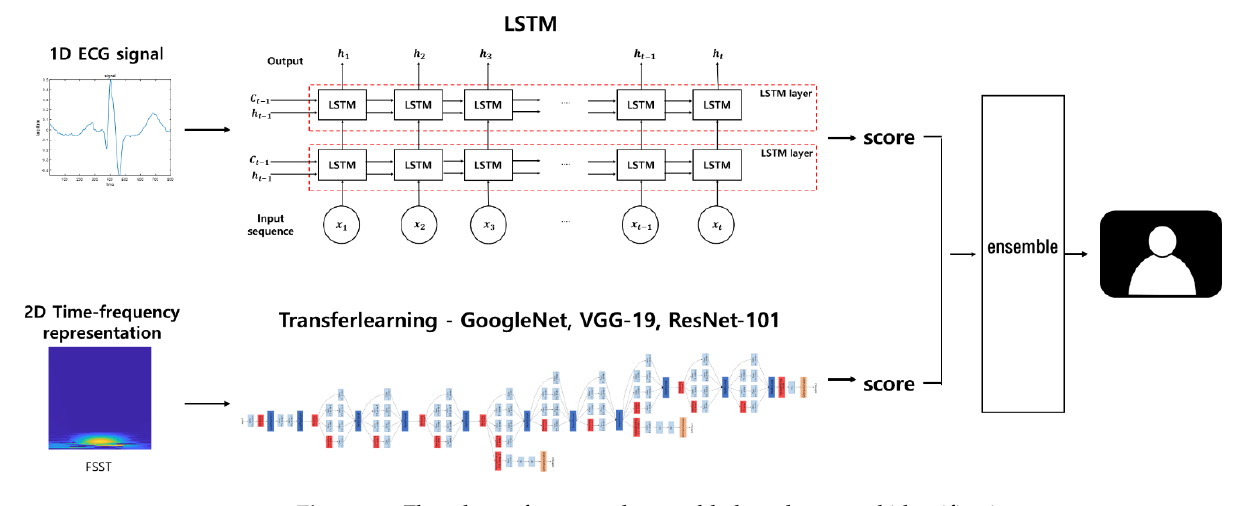
Figure 18. Flowchart of proposed ensemble-based personal identification.